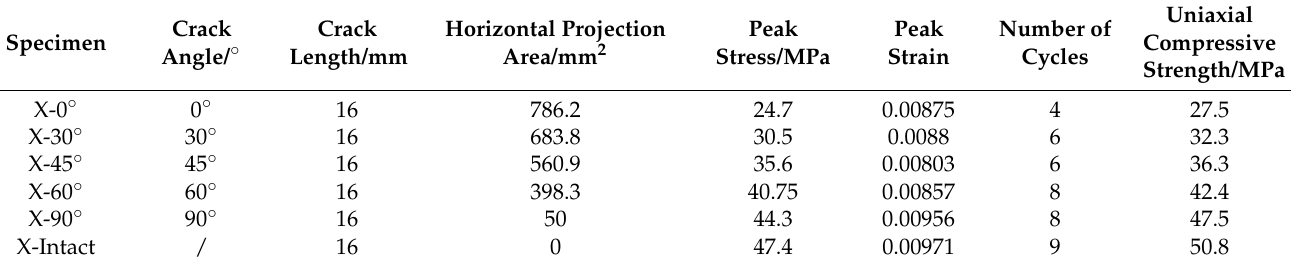
Table 1. Specimen styles and test results for group X.